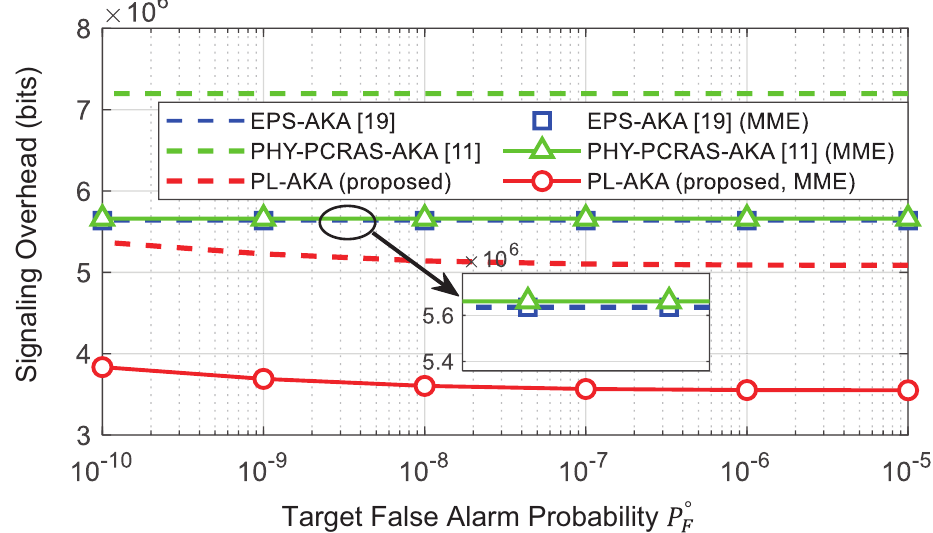
Figure 3. Signaling overheads of PL-AKA and EPS-AKA over various target false alarm probabilities (simulation